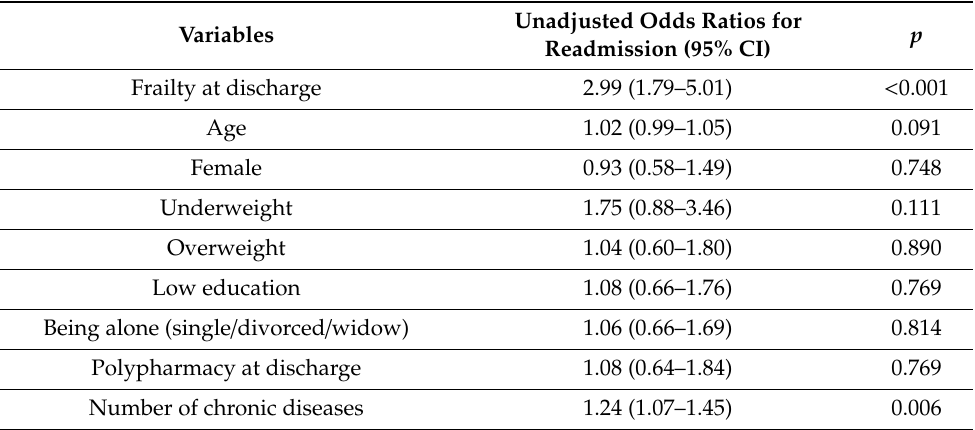
Table 4. Univariate logistic regression of predictive factors for